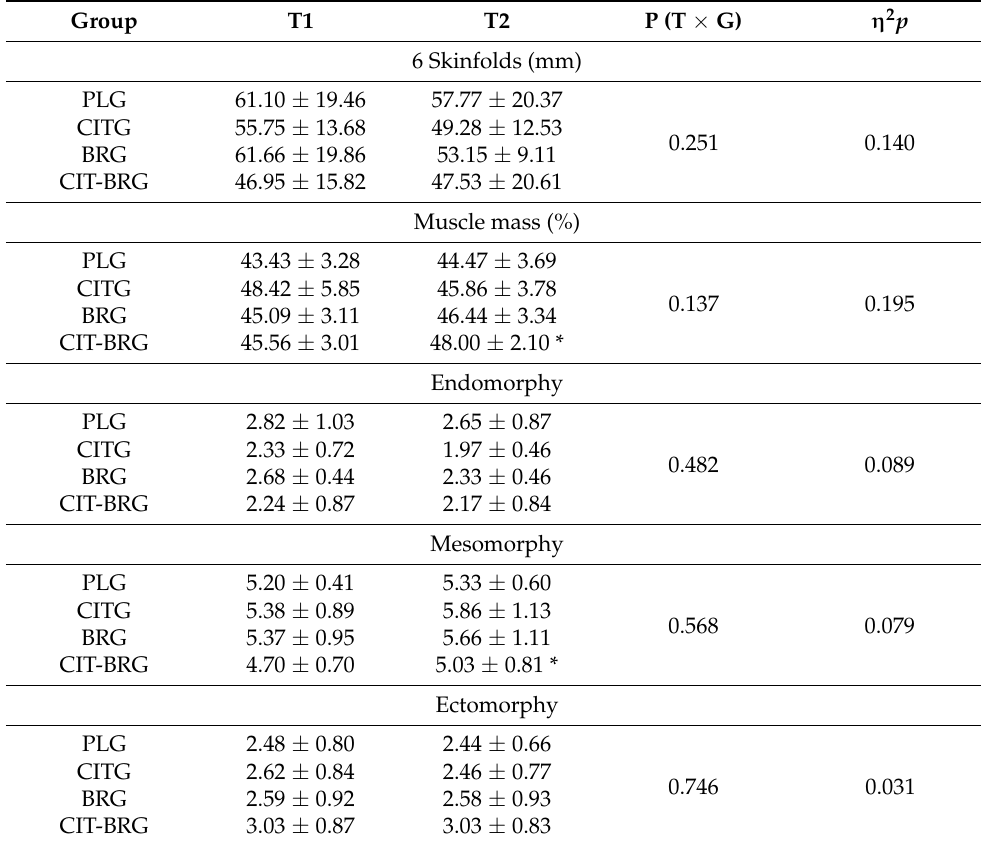
Table 1. Body composition and somatotype data in the four study groups at the baseline (T1) and after 9 weeks of supplementation